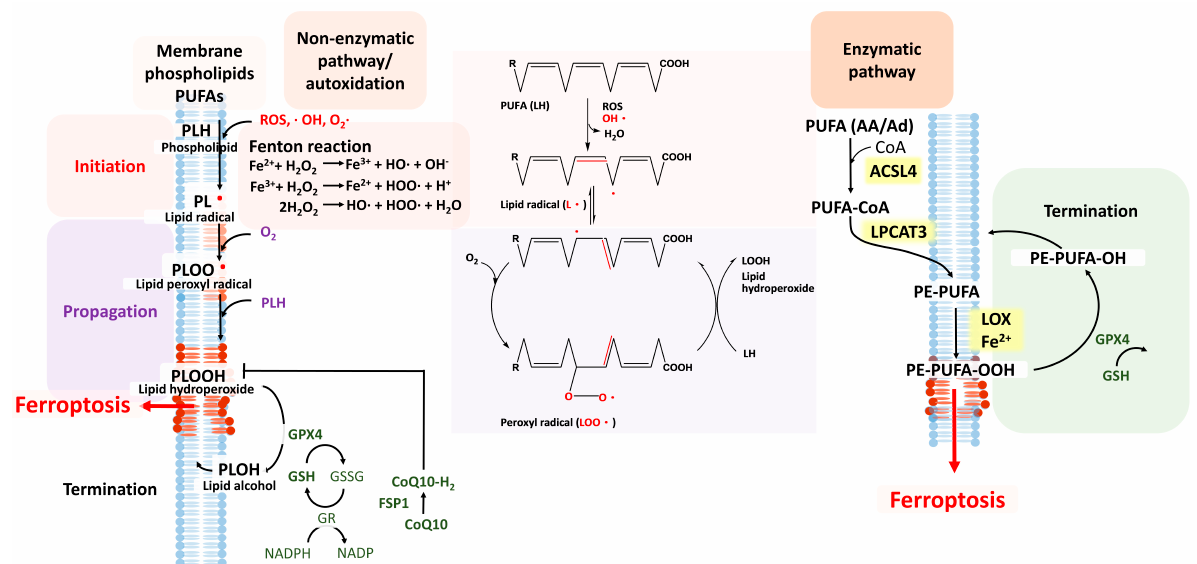
Figure 2. The mechanisms of lipid peroxidation and chemical formula. Lipid peroxidation involves two pathways, the non-enzymatic pathway and the enzymatic pathway. The non-enzymatic pathway includes three steps: initiation, propagation, and termination. In the initiation step, membrane phospholipids are targeted by radicals, such as the hydroxyl radicals, from the Fenton reaction and form lipid radicals. In the propagation step, O 2 added to the lipid radical forms the lipid peroxyl radical and the addition of phospholipid generates lipid hydroperoxide. This forms a loop, creating new lipid peroxyl radicals, and eventually can lead to ferroptosis. In the termination step, antioxidants, such as the system x c − /GSH/GPX4 axis and the CoQ10/FSP1 pathway